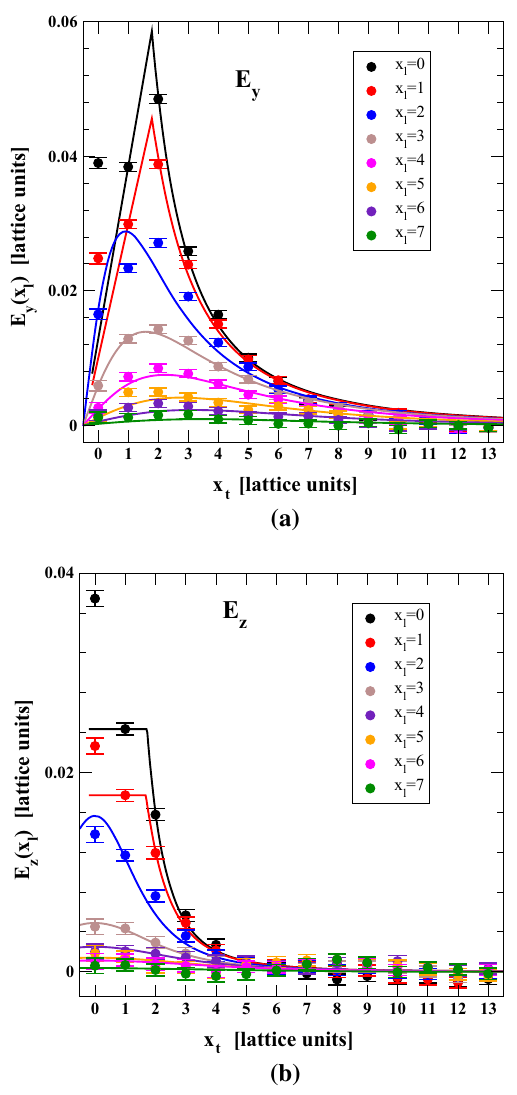
Fig. 12 E y ( x t ) a and E z ( x t ) b and in lattice units at several values of x l at β = 6 . 240, d = 16 a (cid:9) 1 . 14 fm, together with the Coulomb fit according to Eq. (4)